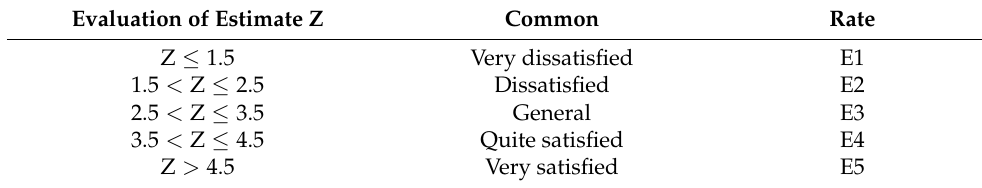
Table 4. Membership function